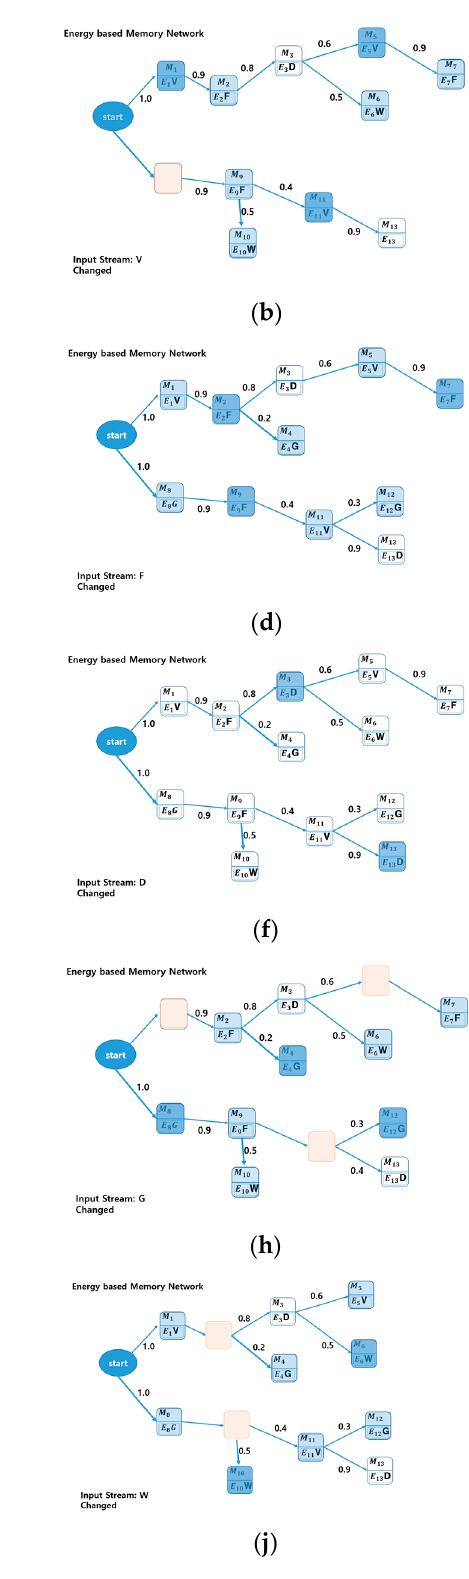
after ERS signal W The changed state after ERS signal D coming ( g ) Qualia Matching with ERS signal G ( h ) The changed